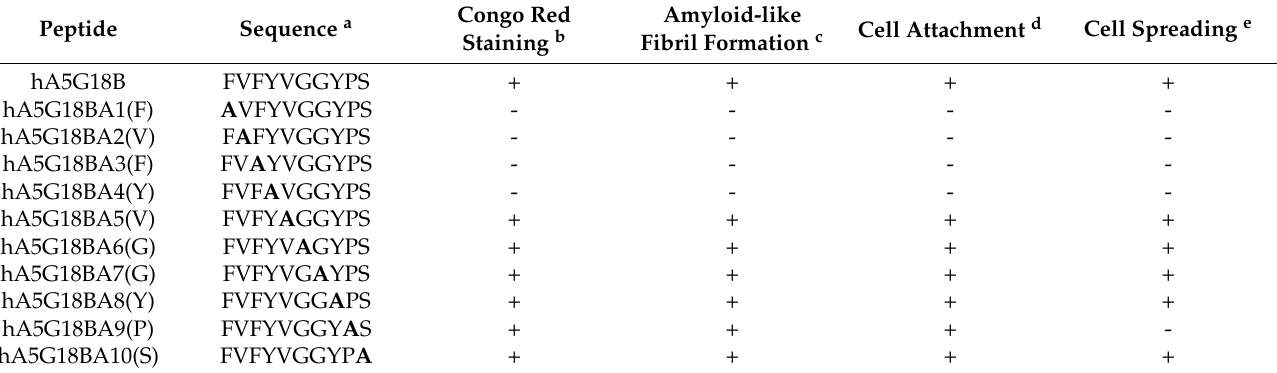
Table 2. Biological activities of hA5G18B and its alanine-substituted